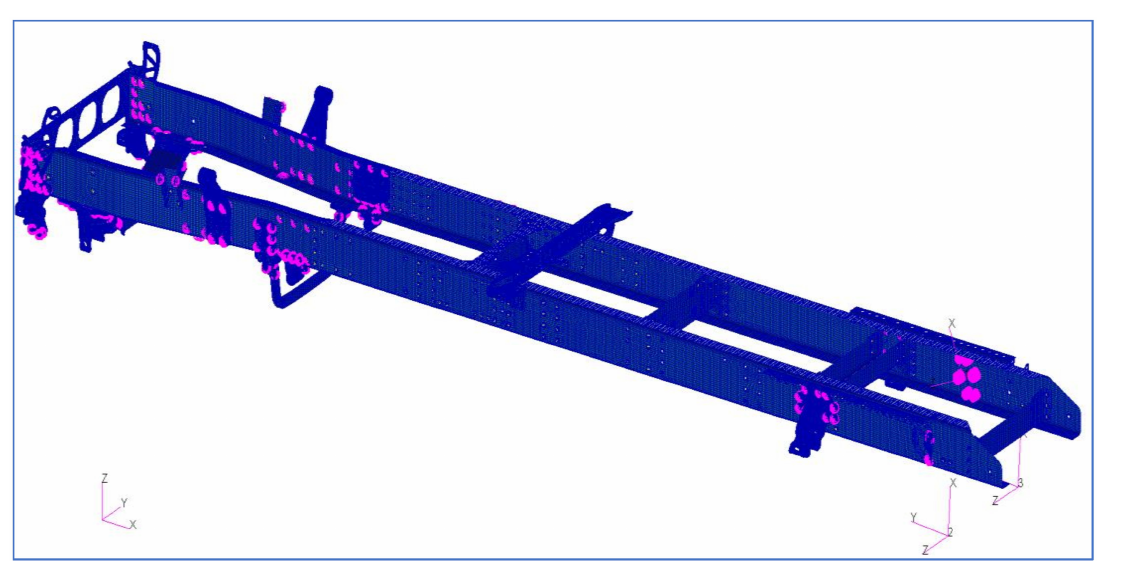
Figure 6. High-fidelity model of the baseline design.